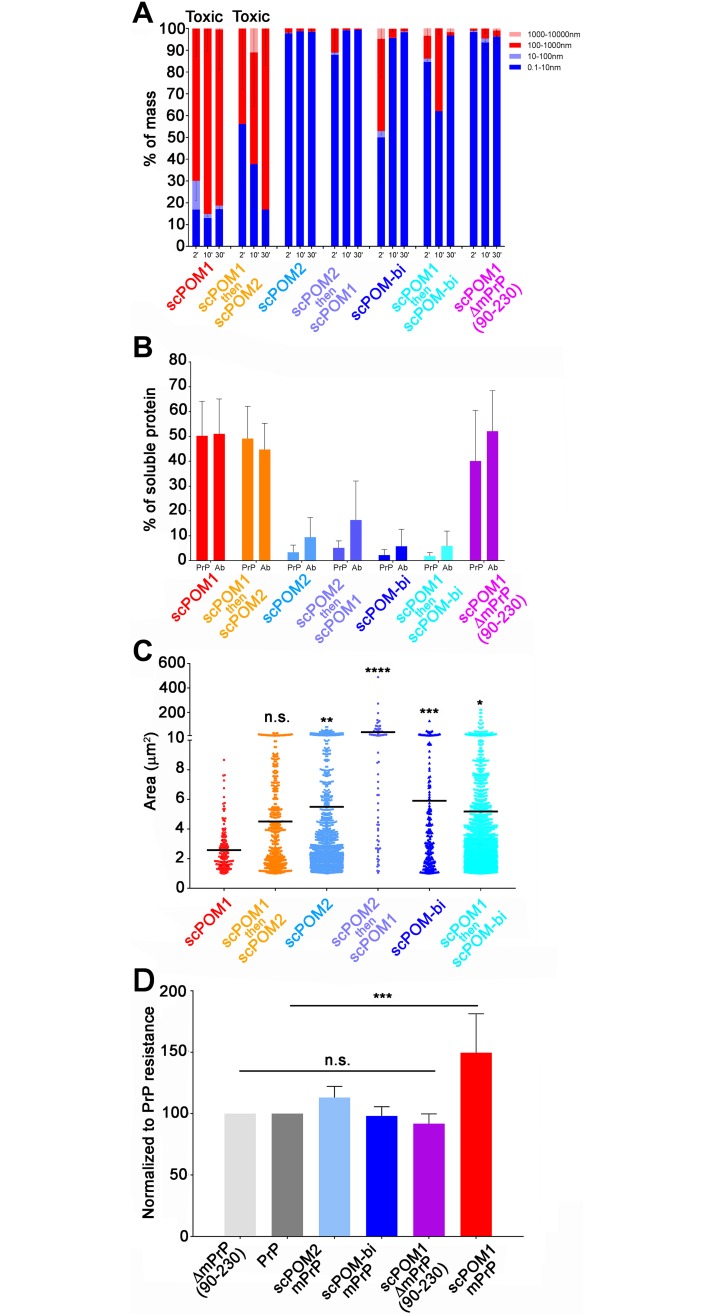
scPOM-bi prevents the formation of soluble, PK resistant oligomers.(A) DLS showed the presence of soluble oligomers (red shades in histograms, reported as percentage) upon addition of the POM1 toxic antibody to recombinant mPrP in vitro. Subsequent addition of POM2 did not remove the oligomers or inhibit toxicity. Smaller species comparable to monomeric forms (blue) were detected in solution when POM1 was in complex with ΔmPrPC90-230, lacking the flexible tail, and when POM2 was added to mPrP prior to POM1 addition. Similarly small species were found when the neuroprotective scPOM-bi was added to mPrP; the bispeficic was also capable of removing the soluble oligomers generated by POM1. DLS data is shown for 3 time points after complex formation. (n = 5 for scPOM1:mPrP, scPOM2:mPrP and scPOM-bi:mPrP; n = 3 for scPOM1:mPrP then scPOM2, scPOM2:mPrP then scPOM1 and scPOM1:mPrP then scPOM-bi) (B) DLS can only detect soluble material. To investigate the presence of insoluble aggregates we formed the mPrP:Ab complexes in vitro, centrifuged them and analyzed the resulting supernatant with PAGE/Western blot. Soluble material was only detected in toxic combinations (POM1:mPrP or POM1:mPrP followed by POM2, red and orange). The percentage of mPrP and antibody in solution (normalized against isolated PrP or antibody) is shown; data from quantification of band intensity on SDS-PAGE (images in S5 Fig—n = 7 for all samples tested). (C) In order to characterize both soluble oligomers and insoluble aggregates we formed the mPrP:Ab complexes in vitro and deposited the resulting material on microscopy slides. Confocal microscopy indicates that toxic antibody combinations (e.g. POM1:mPrP or POM1:mPrP followed by POM2, red and orange) generate species with smaller average size than protective antibody combinations. The surface area of the detected species is reported on the y axis, the horizontal line represents the average. Differences can also be appreciated by visual inspection of the confocal microscopy images (S4 Fig—scPOM1:mPrP n = 166, scPOM2:mPrP n = 1136, scPOM-bi:mPrP n = 204, scPOM1:mPrP then scPOM2 n = 444, scPOM2:mPrP then scPOM1 n = 74 and scPOM1:mPrP then scPOM-bi n = 1767). D) The soluble oligomers generated by POM1 showed increased resistance to in vitro degradation by proteinase K at 2μg/ml (red). Such resistance was abolished when POM1 bound a mPrP construct lacking the FT (light red) or in non-toxic antibodies (shades of blue). Data from quantification of PK resistant bands on western blot, normalized against isolated PrP (images in S6 Fig—scPOM1:mPrP n = 5, scPOM1:ΔPrP n = 3, scPOM2:mPrP n = 4, scPOM-bi:mPrP n = 4).